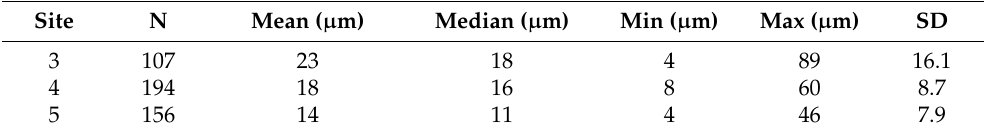
Figure 9. Rounding of grains within the granular layer of weathering rinds (VA—very angular, A—angular, SA/SR—sub-angular/sub-rounded, R—rounded). Table 3. Diameters of the tunnel and circular void micro-structures (sites 3–5).